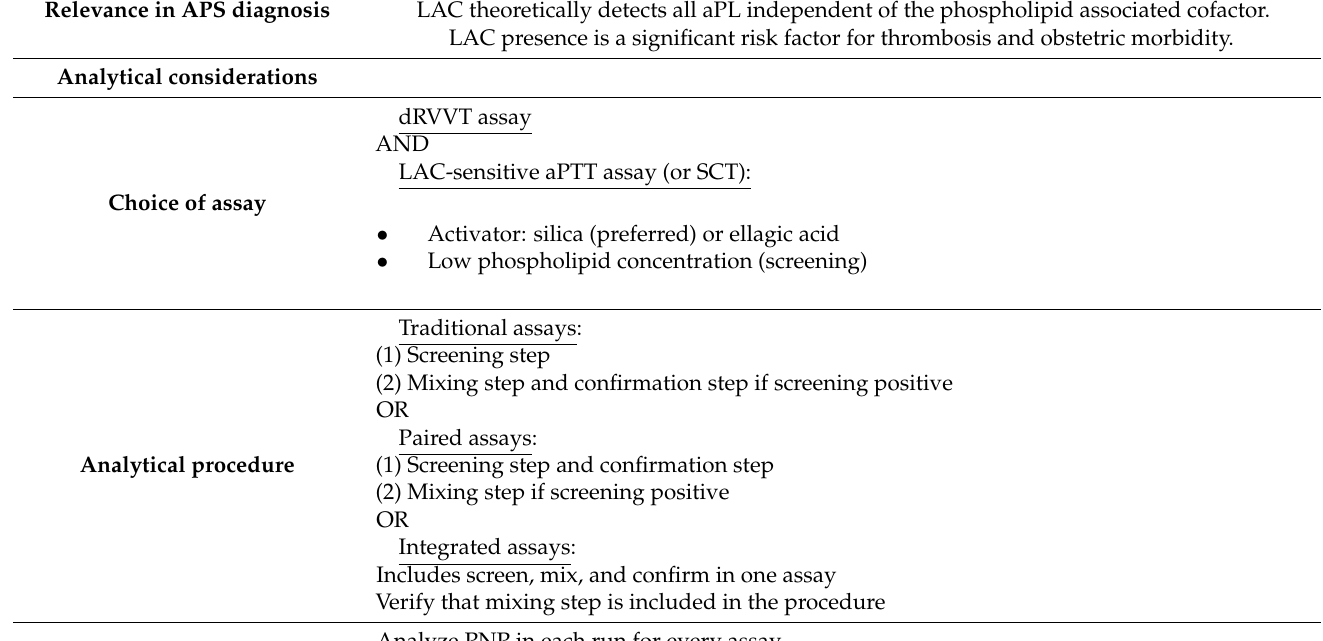
Table 2. Lupus anticoagulant measurement: key messages. Functional, phospholipid-dependent coagulation assay, part of APS classification criteria. LAC theoretically detects all aPL independent of the phospholipid associated cofactor. LAC presence is a significant risk factor for thrombosis and obstetric